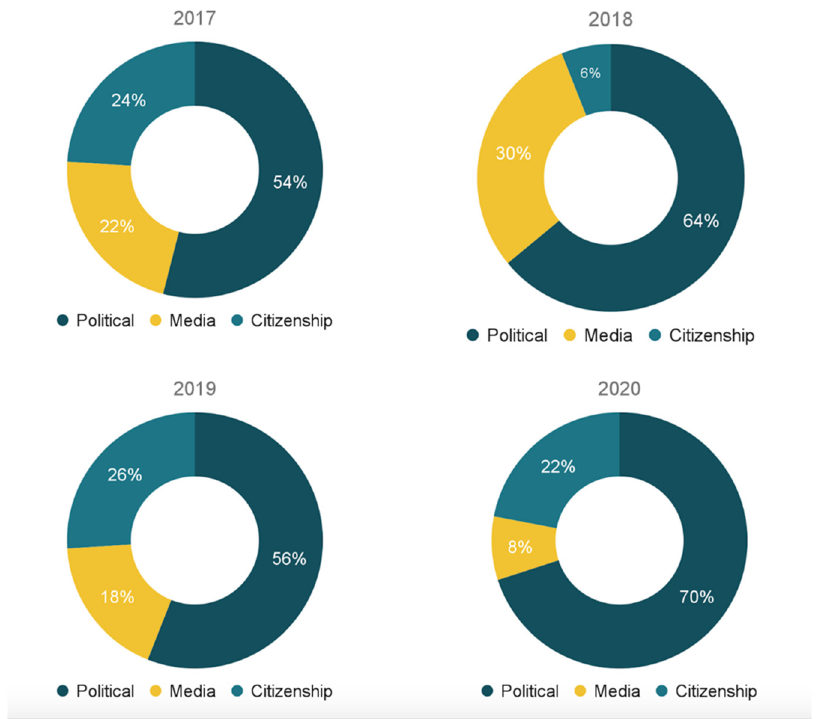
Figure 2. Percentages of the types of accounts the sample of Spanish deputies started to follow in 2017, 2018, 2019 and